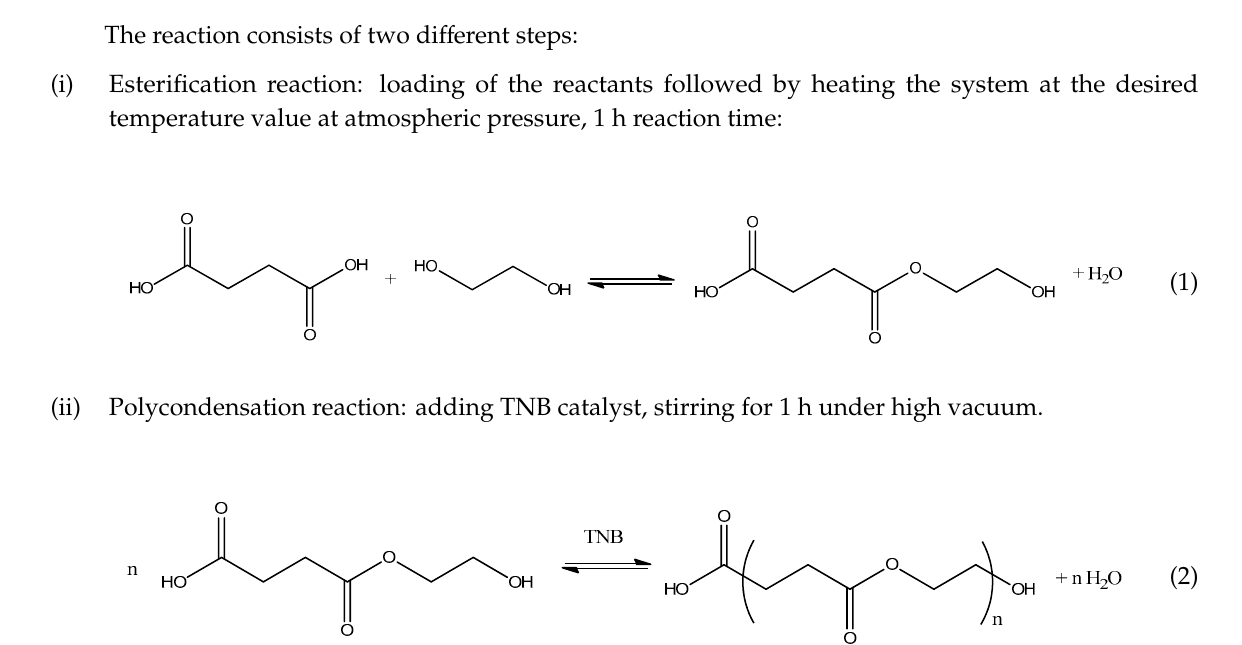
Table 1. Experimental reaction conditions for the synthesis of bS polyol. T (°C): process temperature;